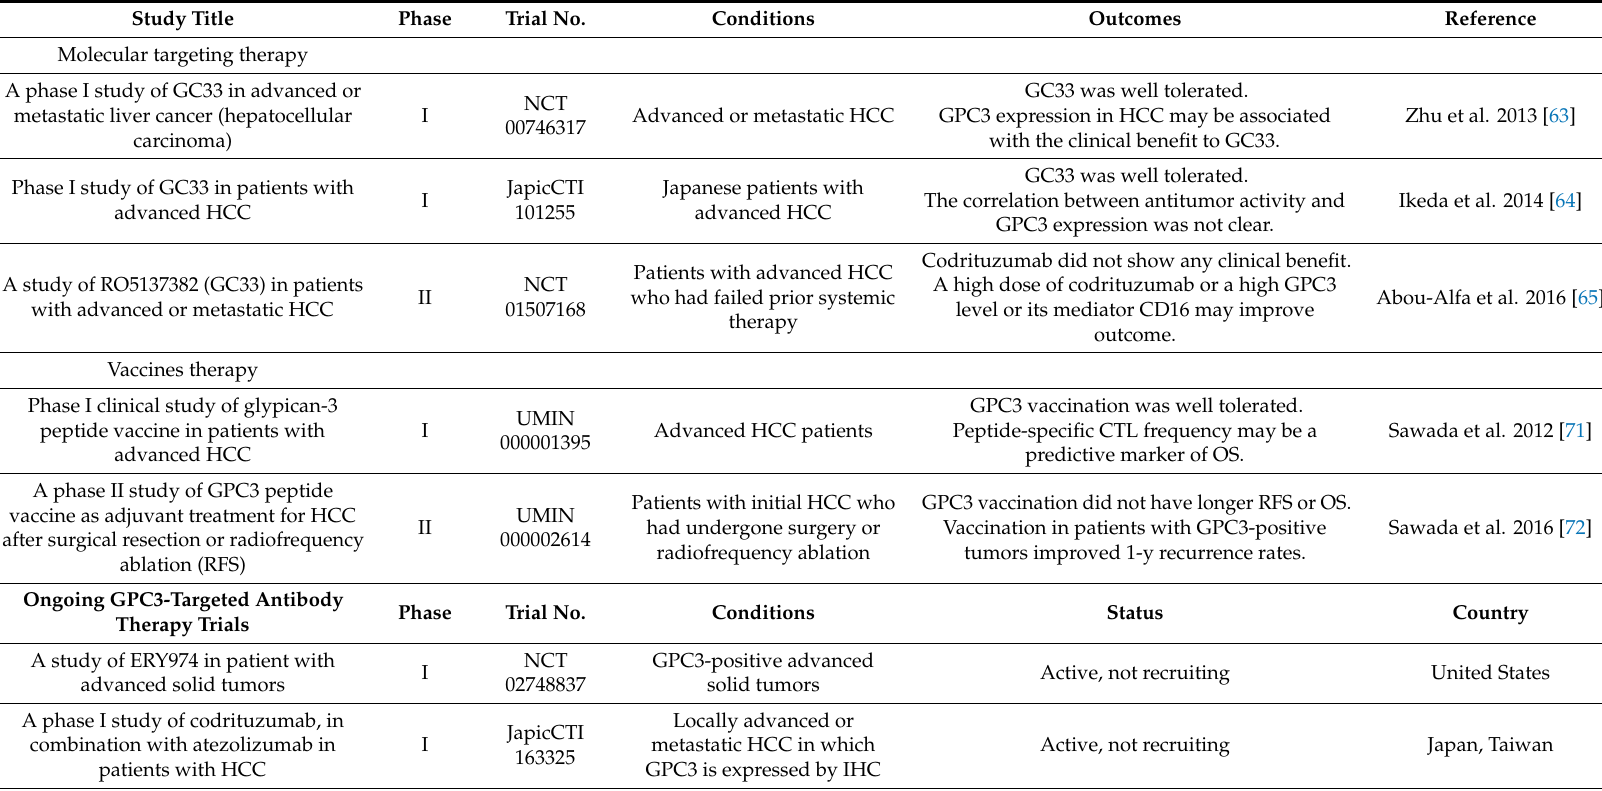
Table 1. Clinical trials of GPC3-targeted antibody therapy and vaccine